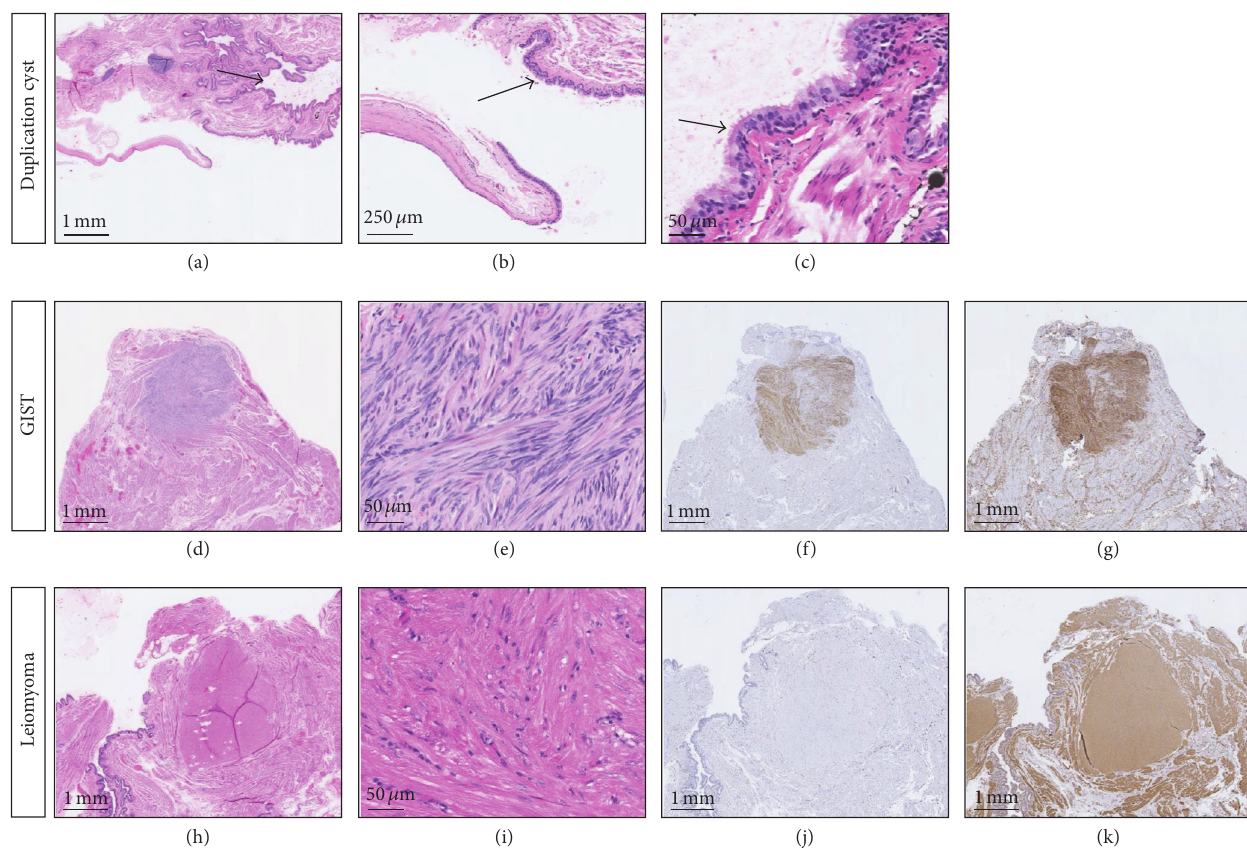
Figure 2: ((a) and (b)) Duplication cyst at low power. The arrows point at the epithelial lining of the cyst, H&E. (c) Pseudostratified ciliated epithelial lining of the duplication cyst at high power. The arrow indicates the presence of cilia, H&E. ((d) and (e)) GIST nodule at low and high power. The tumor cells have spindle shape and mild cytologic atypia, H&E. ((f) and (g)) Immunohistochemistry stains show that the tumor cells are strongly positive for both CD117 (f) and CD34 (g). ((h) and (i)) Leiomyoma at low and high power. The tumor cells have elongated nuclei and abundant cytoplasm, with no cytologic atypia, H&E. ((j) and (k)) Immunohistochemistry stains show that the tumor cells are negative for CD117 (j), while they are strongly positive for SMA